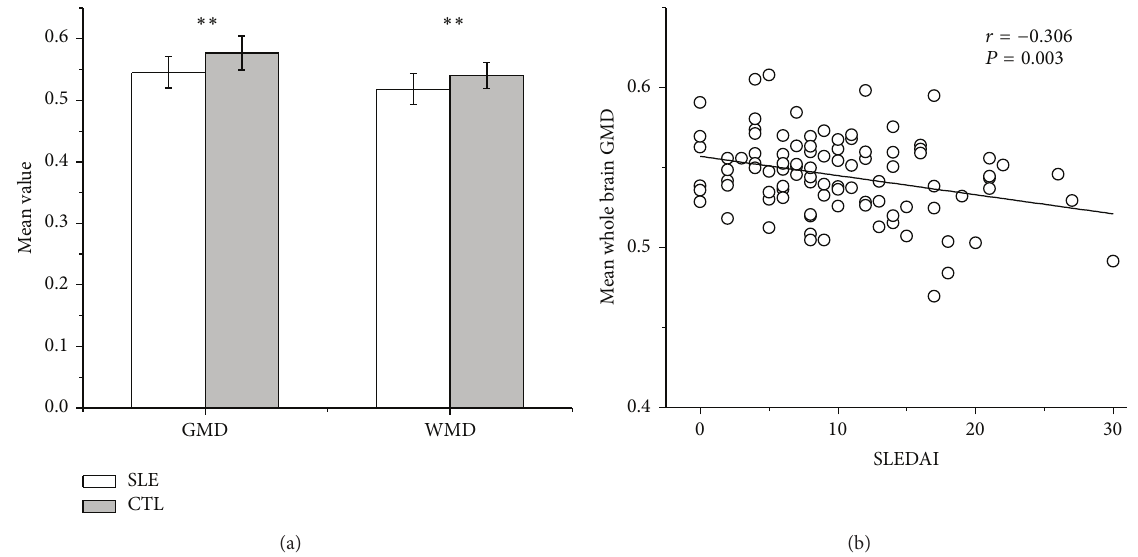
Figure 1: GMD/WMD reduction and the correlation between GMD with disease activity in non-NPSLE. (a) Significantly reduced GMD and WMD in SLE compared with CTLs; (b) negative correlation between GMD and the SLEDAI score of SLE. SLE: systemic lupus erythematosus; CTL: control; GMD: mean whole brain grey matter density; WMD: mean whole brain white matter density; SLEDAI: systemic lupus erythematosus disease activity index. ∗ 𝑃 < 0.05 , ∗∗ 𝑃 < 0.01